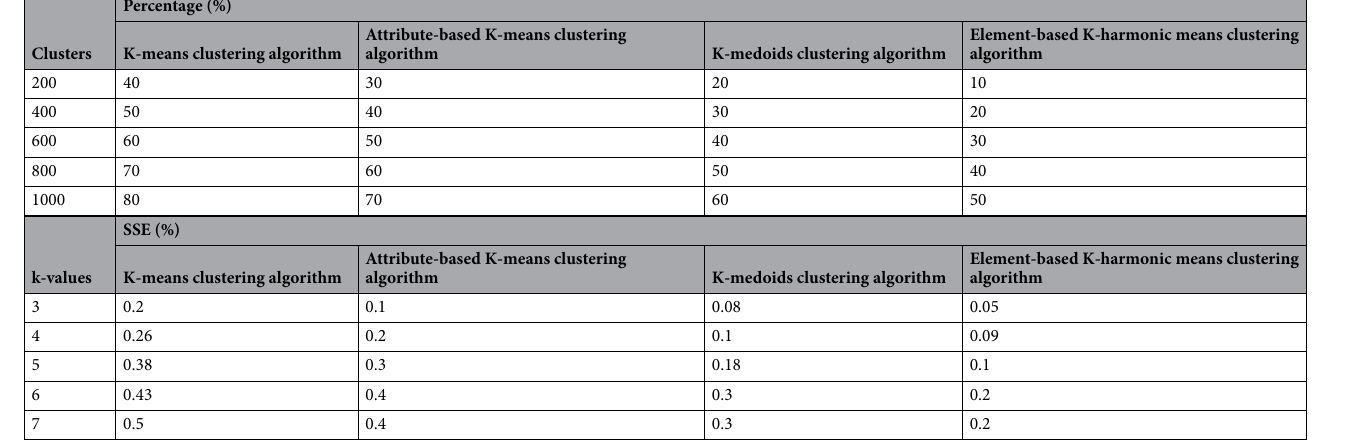
Table 3. SSE dynamics for different k/m